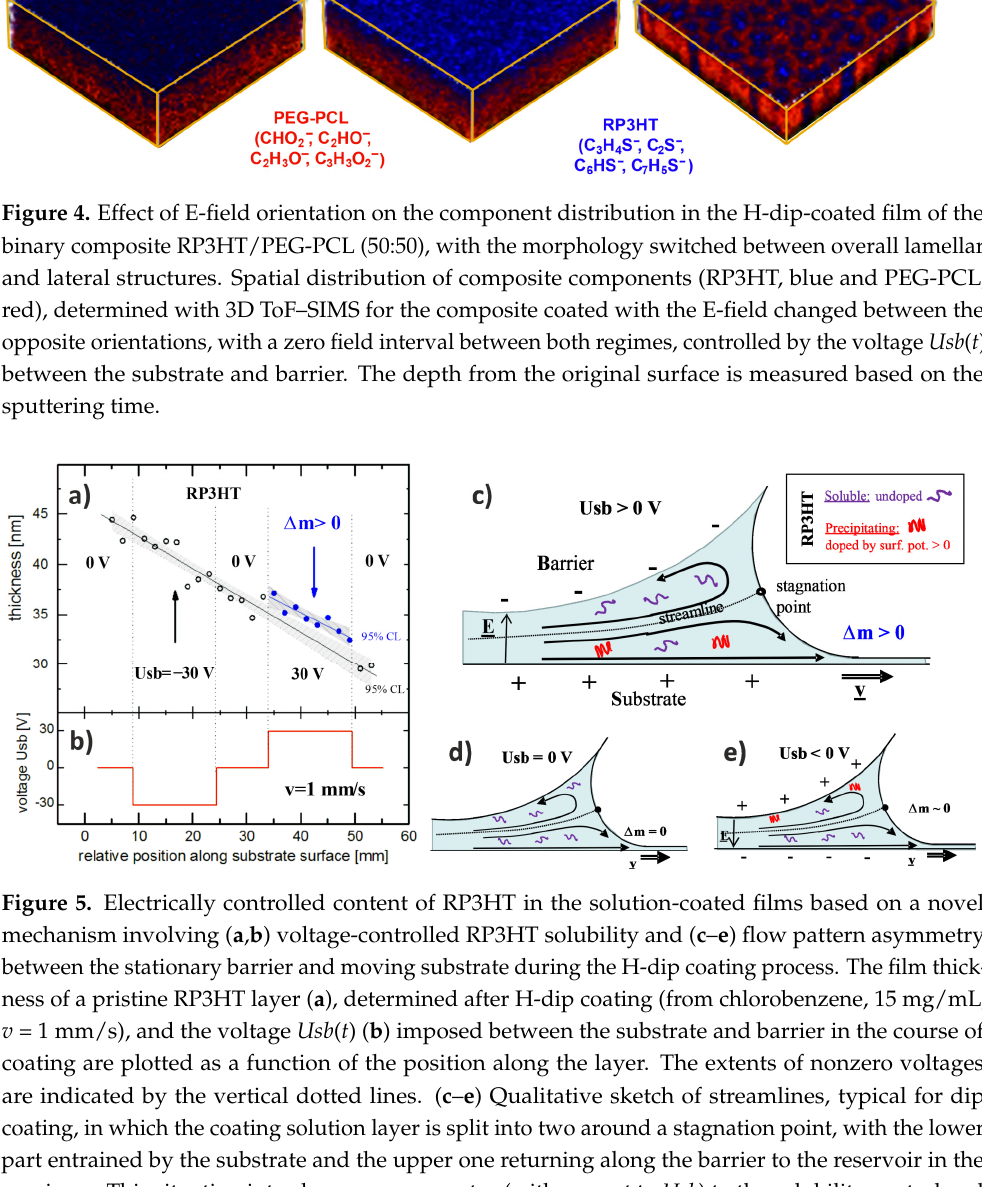
Figure 3. Impact of electric field orientation on the film morphology of H-dip-coated composites: ( a , b ) RP3HT/PEG-PCL (50:50 by weight) and ( c ) RP3HT/PMMA (55:45) electrically switched be- tween the lamellar and lateral structures ( a , b ) and between the phase-inverted droplet-like struc- tures ( c ). AFM height images of the composites coated with the E-field changed between the oppo- site orientations, with a zero field interval between both regimes, controlled by the voltage Usb(t) applied between the substrate and barrier. Equivalent results are obtained for the same Usb values, irrespective of the zero potential being connected to either the barrier ( a ) or the substrate ( b ). ( c ) Fluorescence micrographs of the RP3HT-rich phase revealing the AFM height contrast between the phase-separated domains of RP3HT/PMMA.